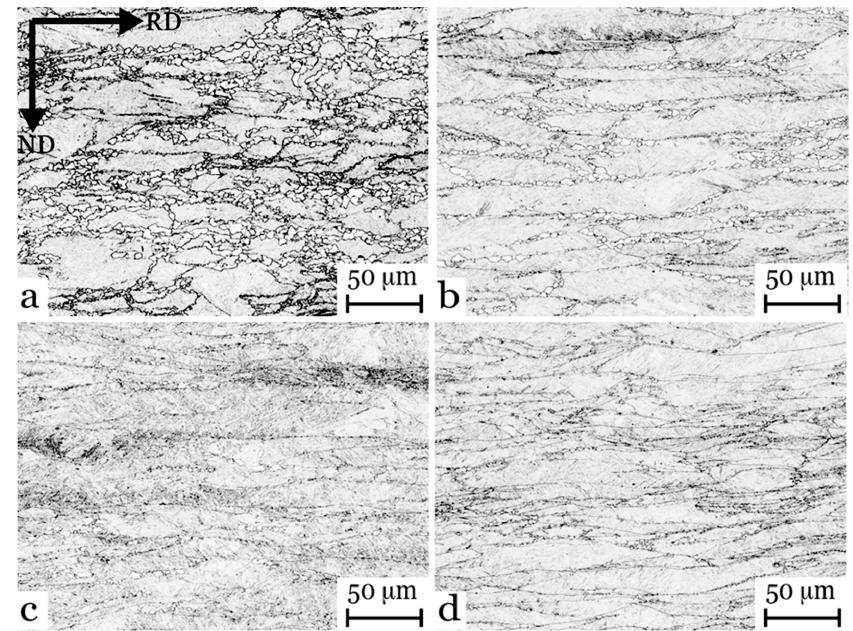
Figure 2. Prior austenite grain boundaries of the investigated steels with FRT of 800 °C: ( a ) 0Mo, ( b ) 0.25Mo, ( c ) 0.5Mo, and ( d ) 0.25Mo–Nb. Grain boundary ferrite can also be discerned. RD = rolling direction, ND = normal direction.